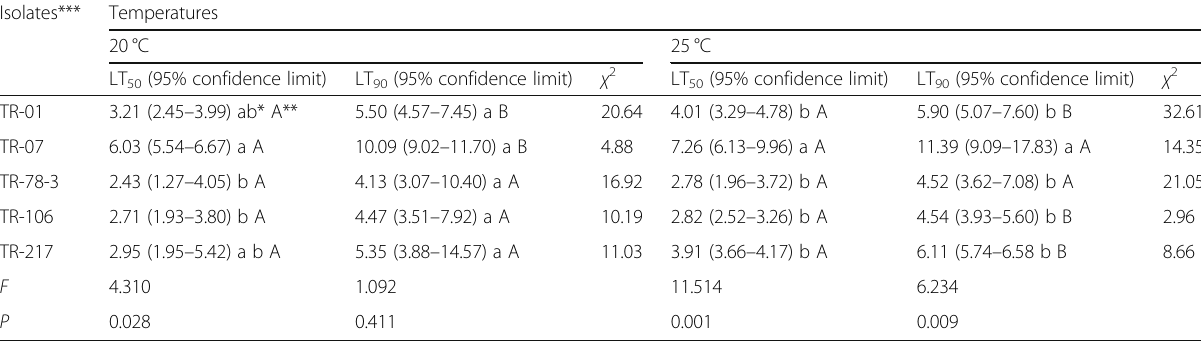
Table 2 Lethal time (LT 50 and LT 90 ) for Sitophilus granarius treated with the tested entomopathogenic fungal isolates at 20 and 25 °C Isolates***